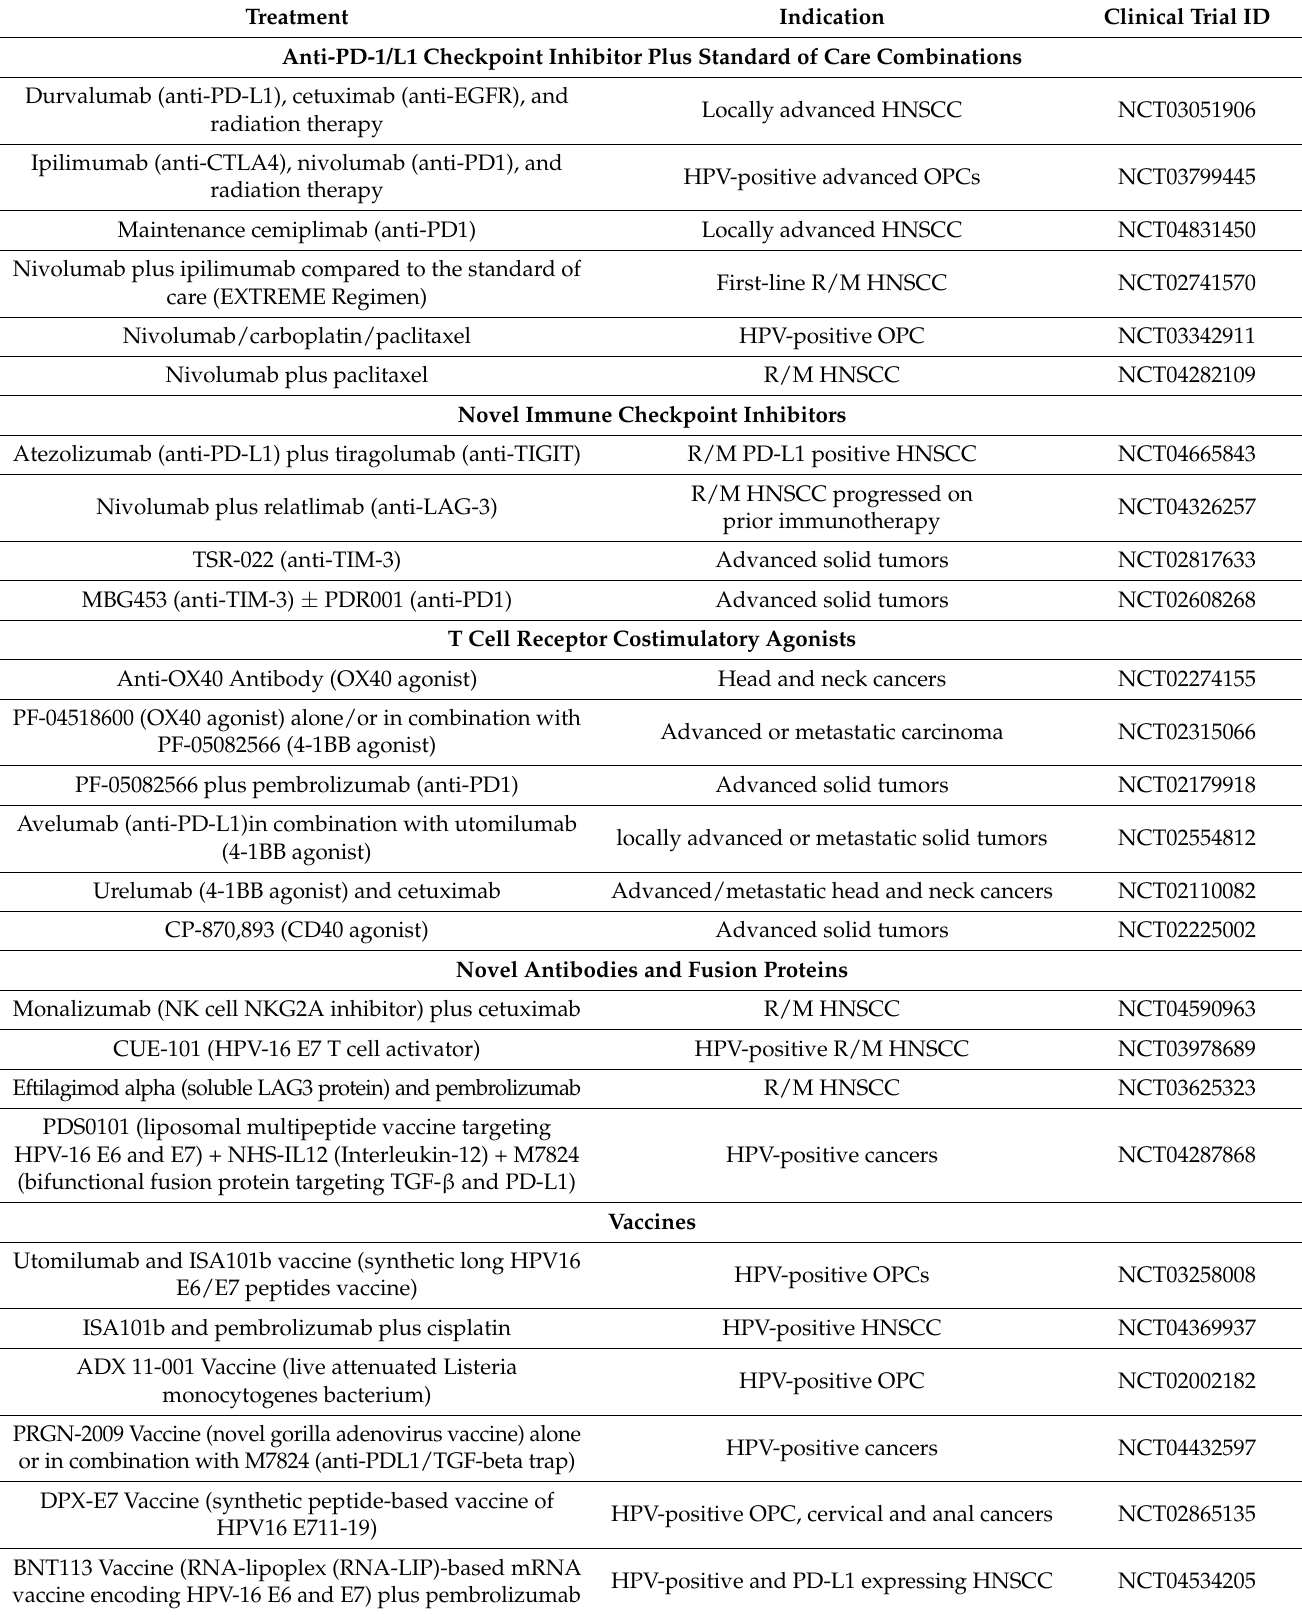
Table 1. Clinical trials evaluating novel immunotherapies in HPV-positive HNSCC. Treatment Indication Clinical Trial